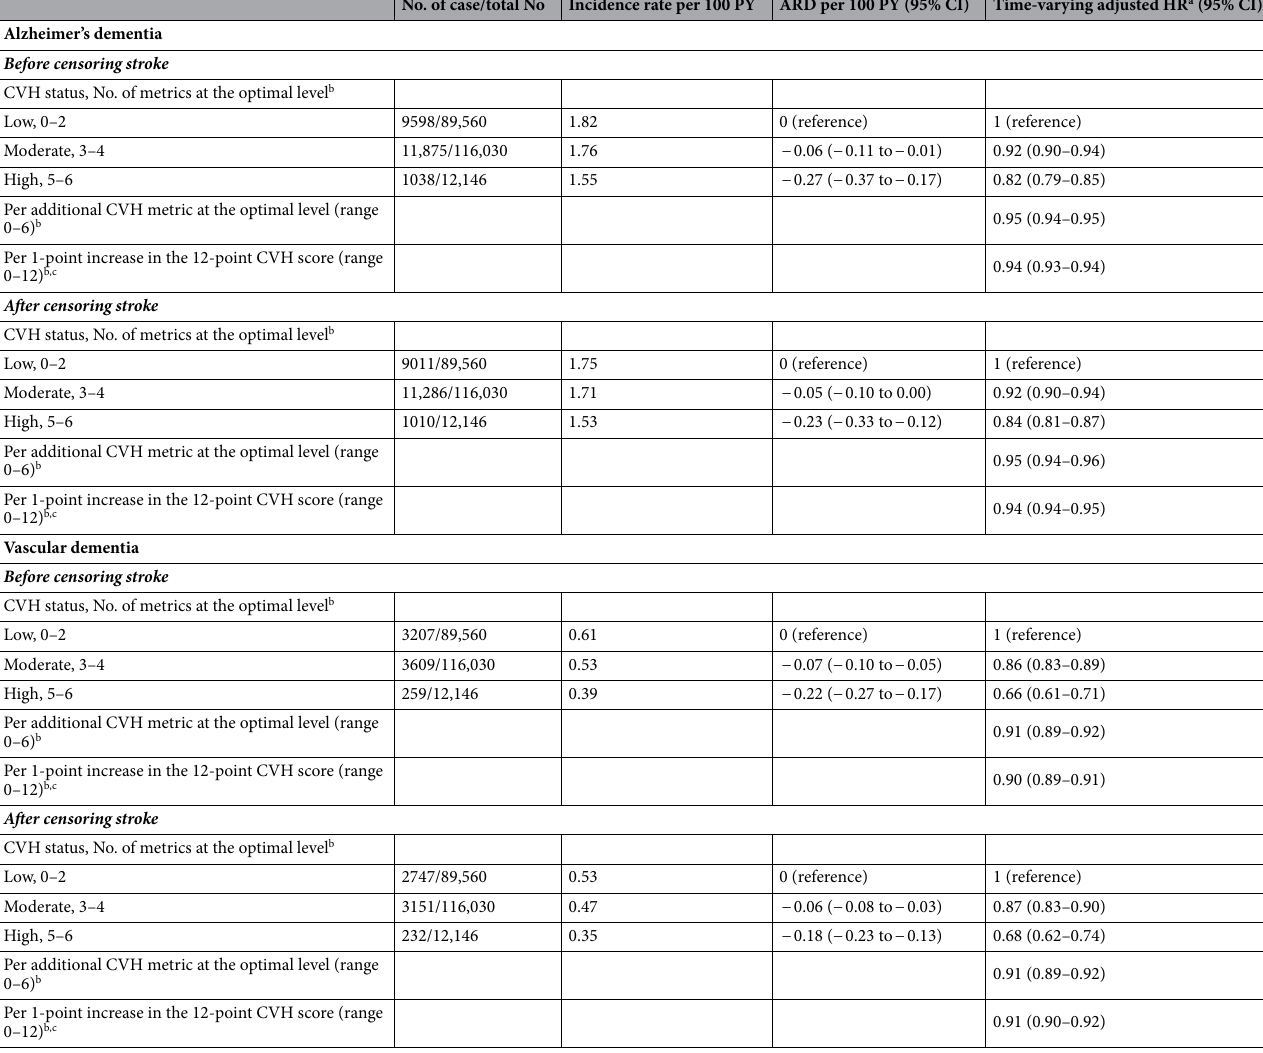
Table 3. Incidence rates, absolute rate differences, and time-varying HRs for Alzheimer’s and vascular dementia according to CVH Status and increasing number of optimal CVH metrics and CVH scores. a HRs with 95% CIs were estimated by time-varying Cox proportional hazard models over a median follow-up of 6.3 years (after censoring stroke, 6.3 years) for Alzheimer’s dementia and 6.4 years (after censoring stroke, 6.3 years) for vascular dementia. HRs were adjusted for age, sex, economic status, living area, comorbidities (AF, HF, MI, coronary heart disease, PAD, anemia, CKD, hyperthyroidism, hypothyroidism, osteoporosis, sleep apnea, COPD, chronic liver disease, and cancer), medications (oral anticoagulants, antiplatelet agents), depressive mood, lower extremity function, and cognitive function at baseline. b CVH status, per additional CVH metric at the optimal level and per 1-point increase in the 12-point CVH score, were used as time- varying variables. c The continuous 12-point CVH score (range, higher score indicating higher CVH) was calculated by assigning 0 (poor), 1 (intermediate), and 2 (optimal) points to each of the six metrics and summing them. AF atrial fibrillation, ARD absolute rate difference, CI confidence interval, CKD chronic kidney disease, COPD chronic obstructive pulmonary disease, CVH cardiovascular health, HF heart failure, HR hazard ratio, MI myocardial infarction, PAD peripheral artery disease, PY